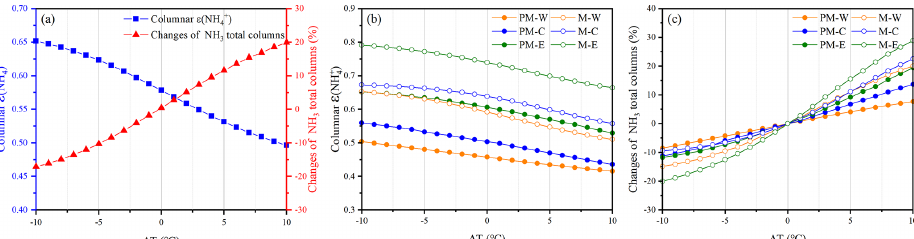
Figure 3. Columnar ε (NH + ) and changes in NH 3 total columns with the changes in temperatures predicted by ISORROPIA-II. (a) Mean 4 columnar ε (NH + ) and changes in NH 3 total columns over the IGP from June to August 2010. (b) Columnar ε (NH + 4 in NH 3 total columns over the western IGP during pre-monsoon (PM-W), the central IGP during pre-monsoon (PM-C), the eastern IGP during pre-monsoon (PM-E), the western IGP during monsoon (M-W), the central IGP during monsoon (M-C), and the eastern IGP during monsoon